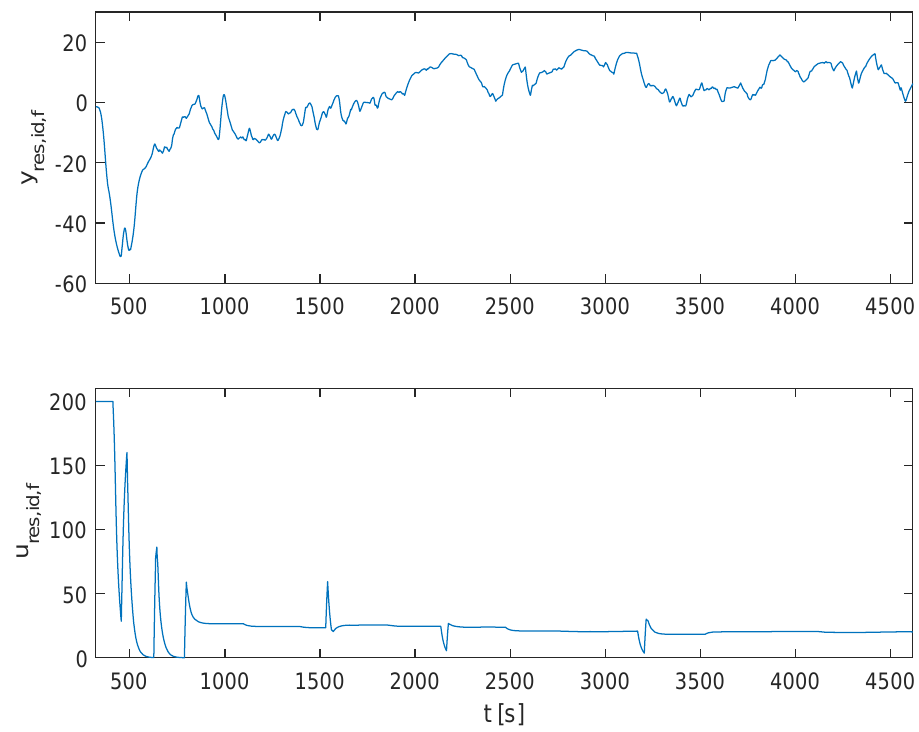
Figure 4. The identification signals for the residual dynamic model y res , id , f and u res , id , f